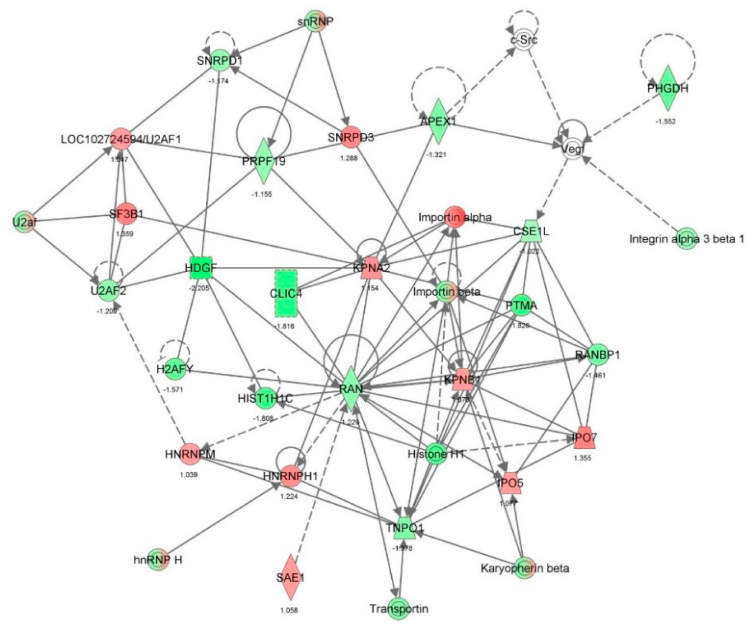
Figure 11. Vancomycin regulated molecular transport, protein trafficking, and RNA post-transcriptional modification. Red indicates an up-regulation; green indicates a down-regulation. The intensity of green and red colors indicates the degree of down- or up-regulation. Solid arrow indicates direct interaction and dashed arrow indicates indirect